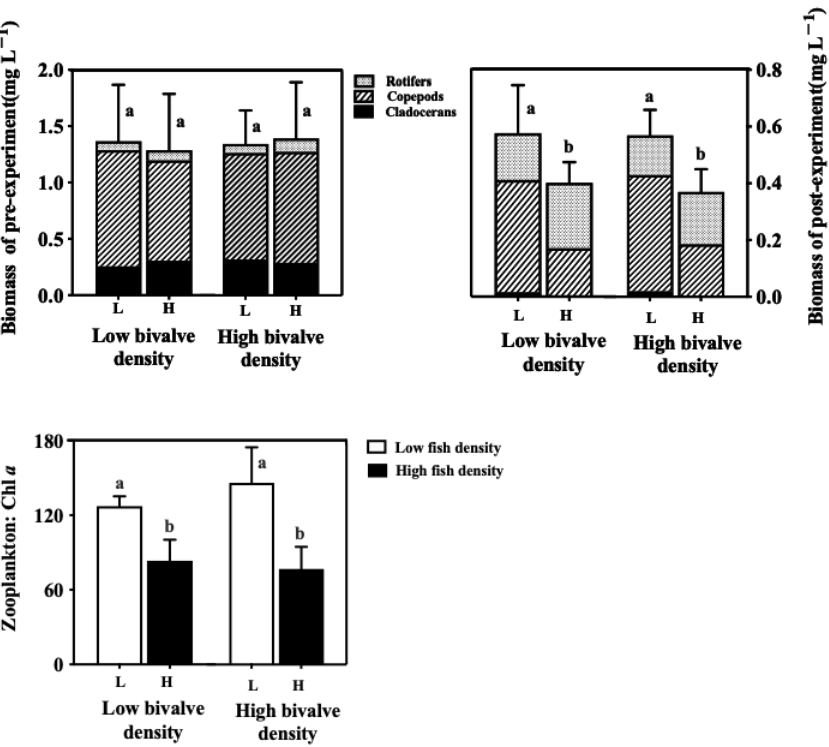
Figure 9. Total zooplankton biomass before ( left ) and after the experiment ( right ) and zooplankton: Chl a after the experiment in the di ff erent treatments (means ± SD). L = low density of fish; H = high density of fish. Di ff erent letters show significant di ff erences among